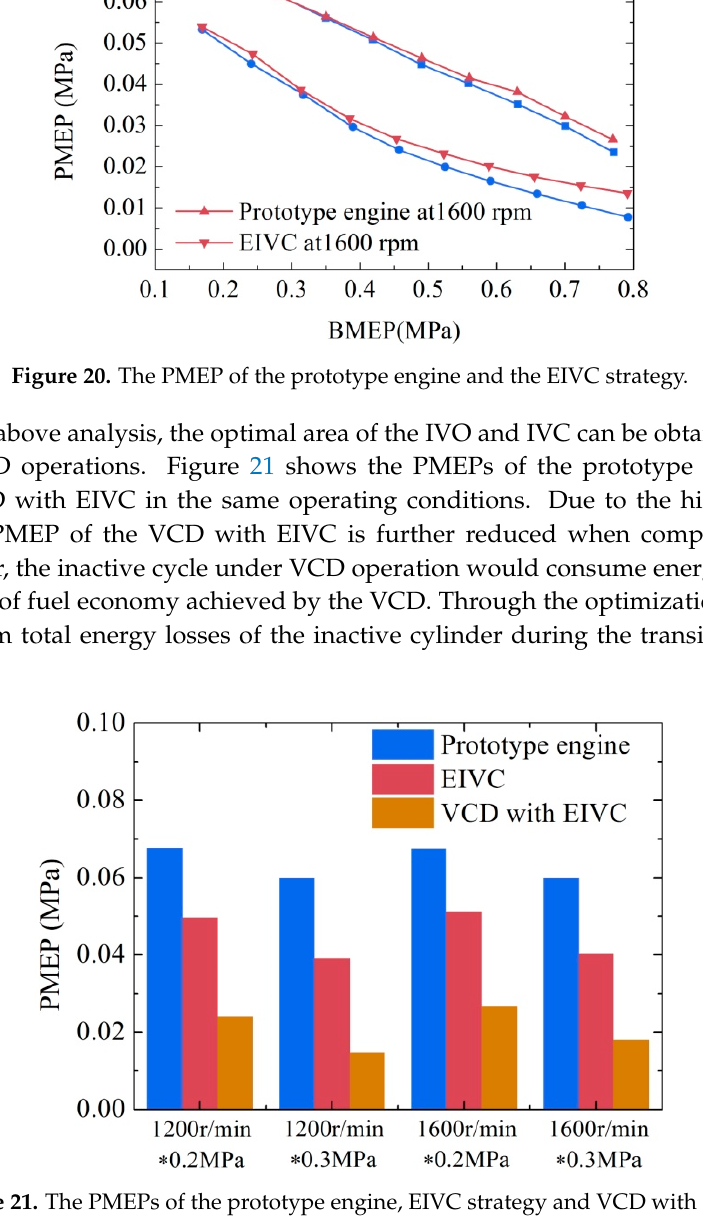
Figure 21. The PMEPs of the prototype engine, EIVC strategy and VCD with EIVC.